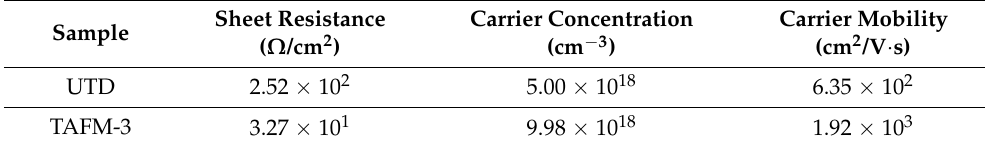
Table 2. Hall Effect measurement result for UTD and TAFM.